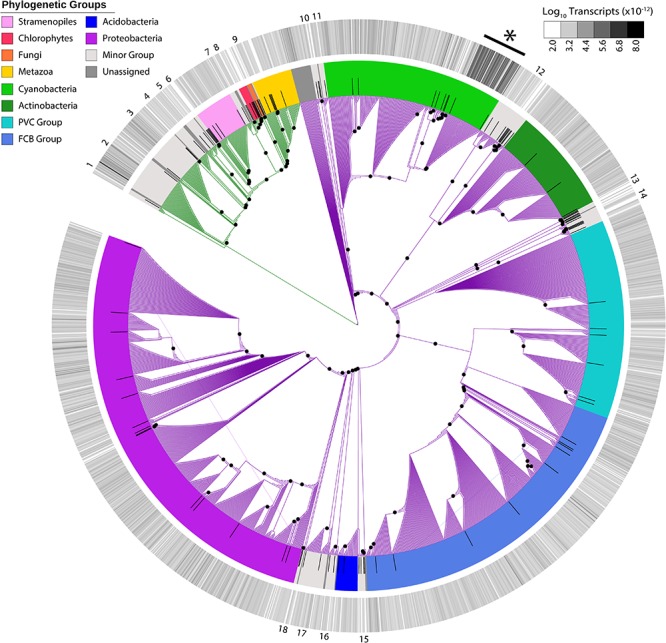
Maximum-likelihood phylogenetic placement of host candidates. Reference proteins are denoted by black bars. Green branches indicate eukaryotic hosts and purple branches indicate bacterial hosts. Colored ring indicates viral family and the outer heatmap ring indicates normalized transcript abundance for each candidate summed for all samples. Numbers on outer edge represent collapsed reference groups (Supplementary Table 2). Black dots represent bootstrap values >0.5. ∗Microcystis-like candidates.